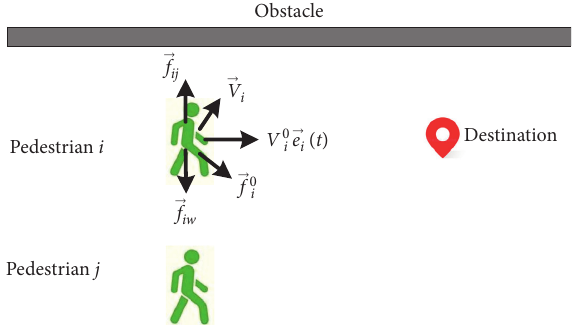
Figure 1: Diagram of the social force